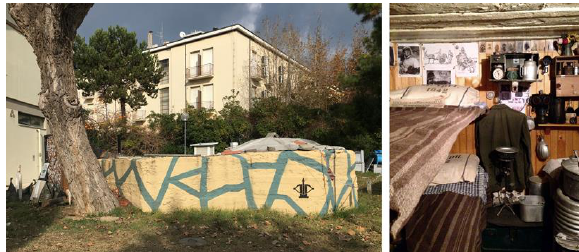
Figure 4. Cesenatico (FC), Examples of CRB360°